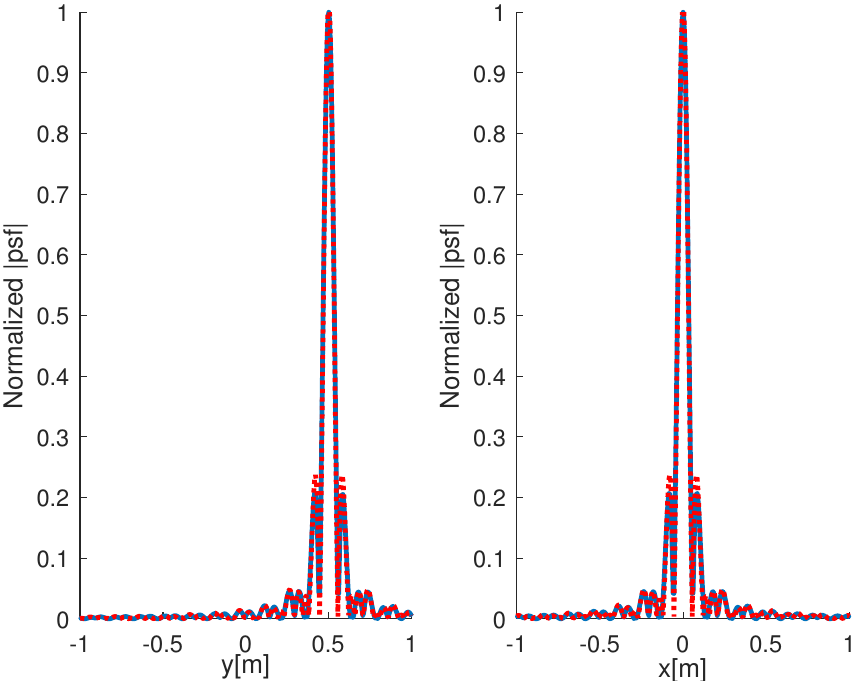
Figure 2. Comparison between the normalized point-spread function amplitude (blue line) and the one returned by (18) (red dotted line). The left panel refers to the cut along the y -axis; the right one to the cut along the x -axis. The adopted frequency band is Ω = [ 0.5,1.5 ] GHz while the observation curve is an ellipse with axes of 2 m and 2.5 m,